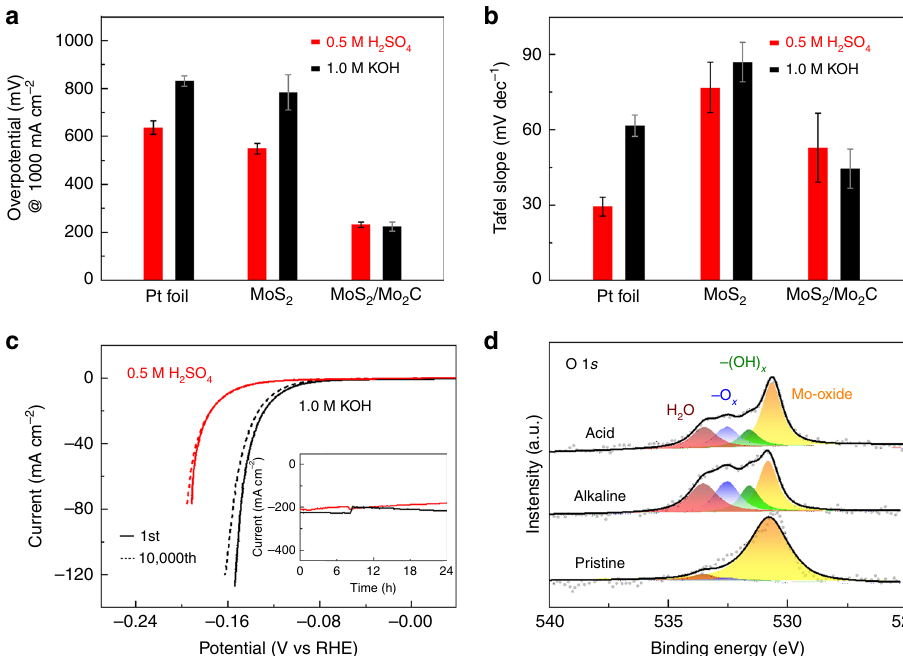
Fig. 3 Performance and surface chemistry of catalysts. a Overpotentials at 1000 mA cm − 2 for a Pt foil, MoS 2 , and MoS 2 /Mo 2 C in acidic and alkaline media. Each sample was measured for three times, and error bars correspond to standard deviations. Source data are provided as a Source Data fi le. b Tafel slopes (at a current density smaller than 50 mA cm − 2 ) for a Pt foil, MoS 2 , and MoS 2 /Mo 2 C in acidic and alkaline media. Each sample was measured for three times, and error bars correspond to standard deviations. Source data are provided as a Source Data fi le. c Polarization curves of the MoS 2 /Mo 2 C catalyst during the initial scan and after 10,000 scans. Inset shows the chronoamperometric responses (i – t) recorded on MoS 2 /Mo 2 C for 24 h in both media. d O 1 s X-ray photoelectron spectroscopy (XPS) spectra of the MoS 2 /Mo 2 C sample before and after 100 cycles in KOH (1.0 M) and H 2 SO 4 (0.5 M)